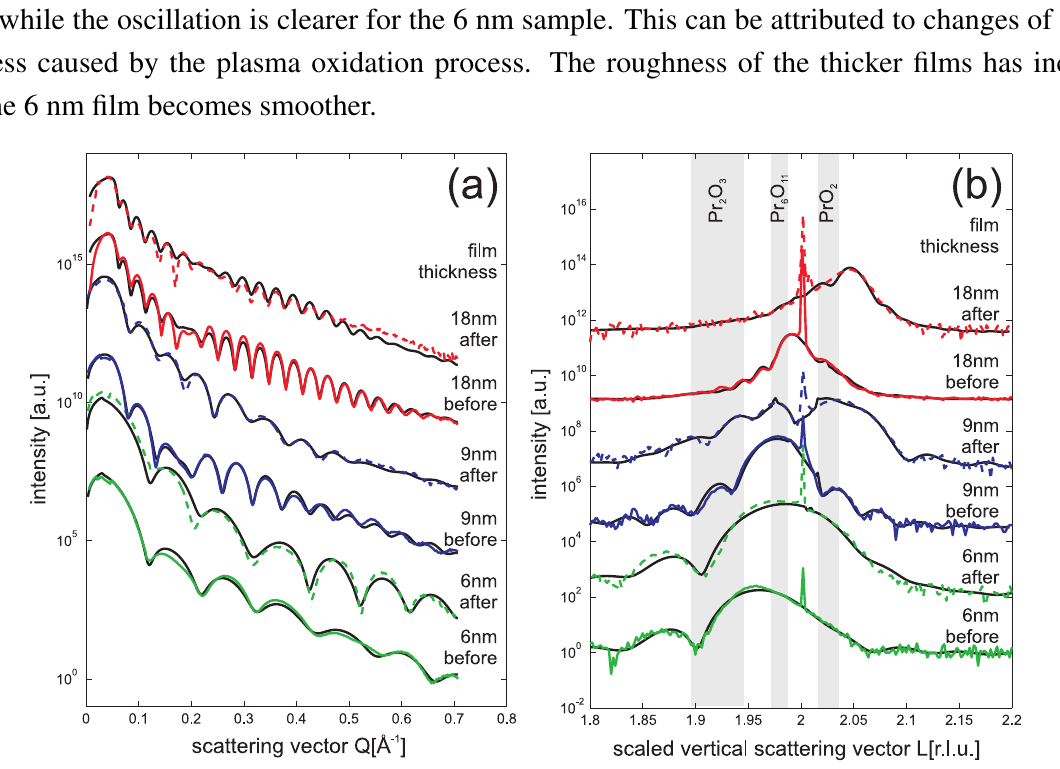
Figure 2. SR-XRR ( a ) and SR-XRD ((00L) crystal truncation rod) ( b ) data obtained from praseodymia films of different thickness: 6 nm (green line), 9 nm (blue line) and 18 nm